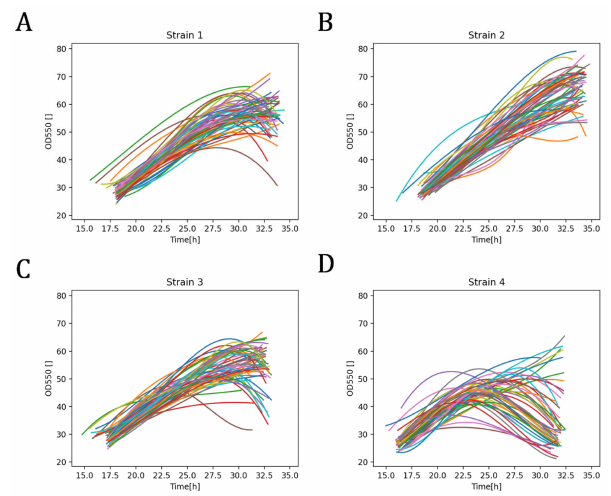
Figure A1. Visualization of the OD against time of ( A ) strain 1, ( B ) strain 2, ( C ) strain 3 and ( D ) strain 4. Each line indicates a different